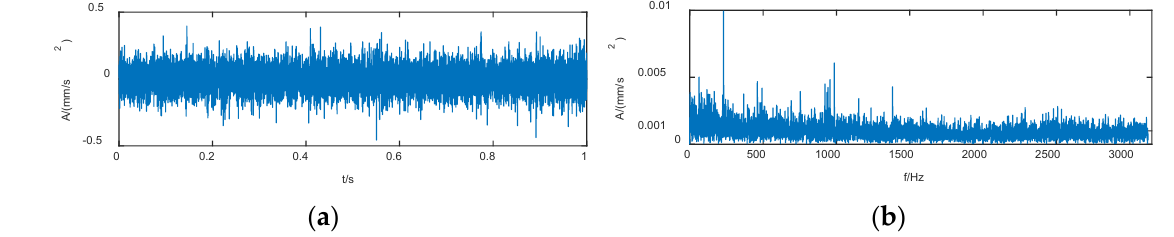
Figure 6. Time-domain waveform and envelope spectrum of the original signal; ( a ) time-domain waveform; ( b ) spectral envelope.